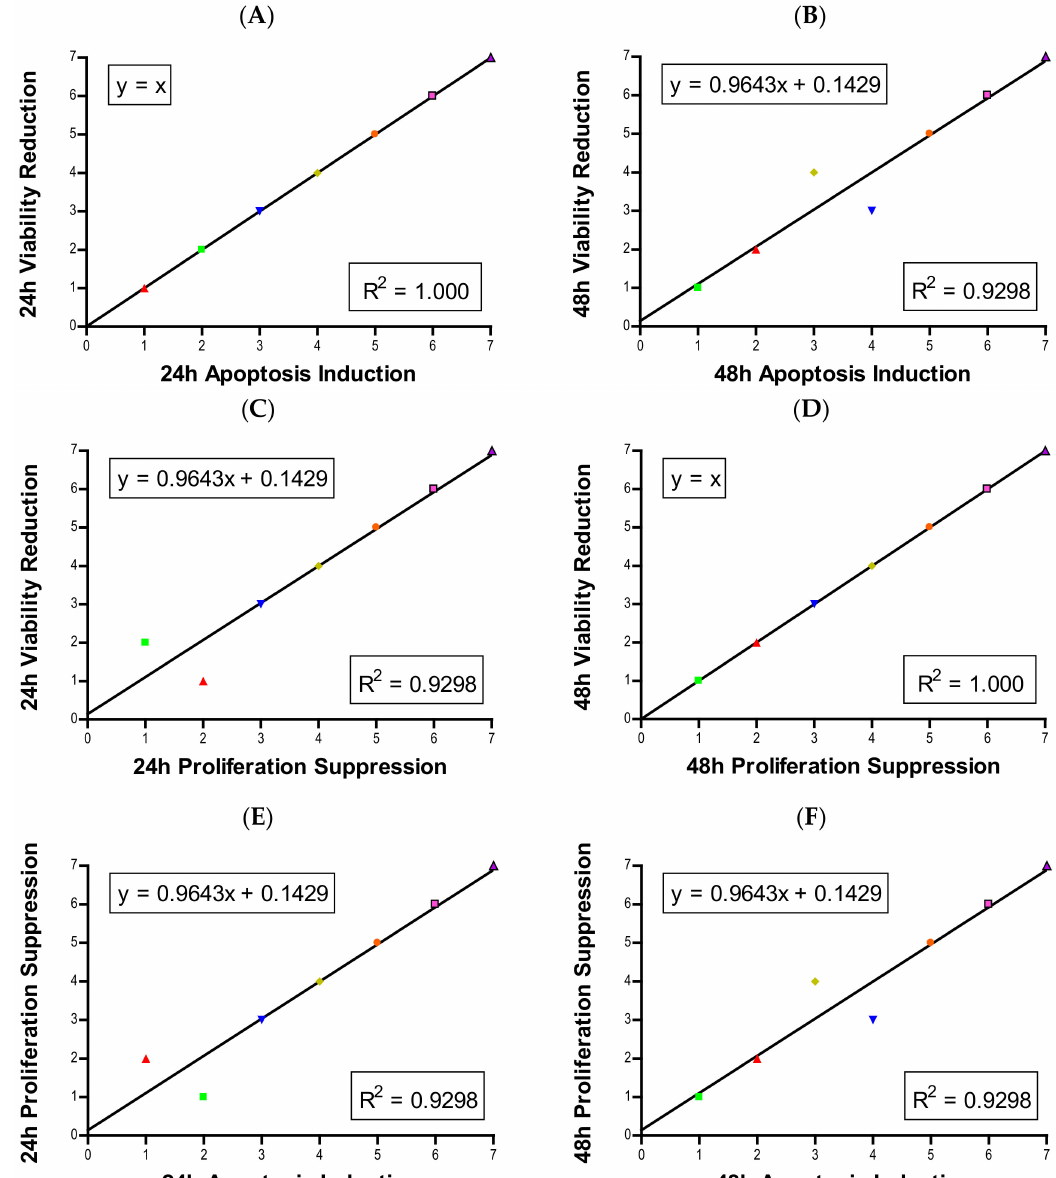
Figure 6. Linear regression analysis of ( A ) 24 h viability vs. proliferation ( B ) 48 h viability vs. proliferation ( C ) 24 h viability vs. apoptosis ( D ) 48 h viability vs. apoptosis ( E ) 24 h proliferation vs. apoptosis ( F ) 48 h proliferation vs.